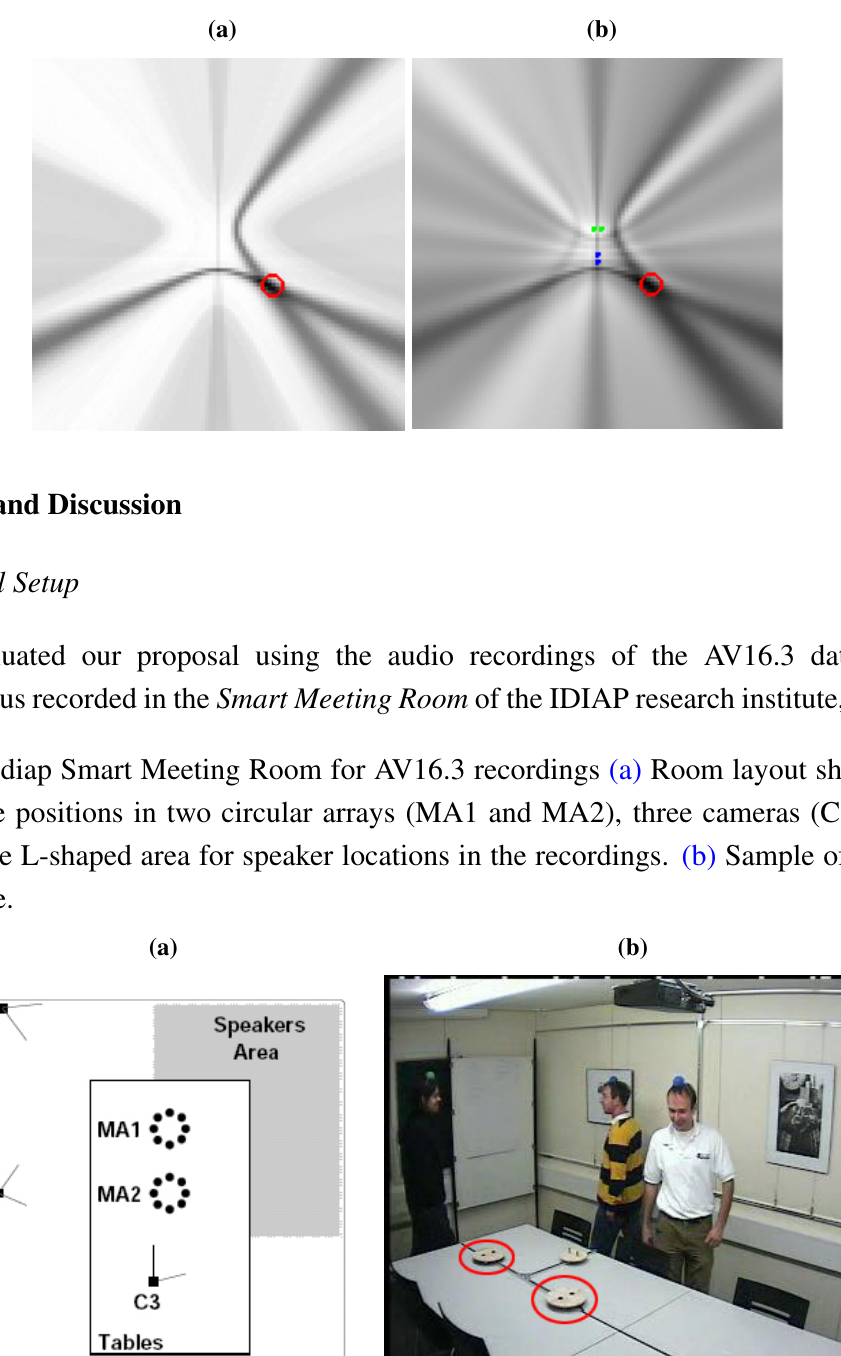
Figure 6. Comparison between real SRP-PHAT power map and its denoised version. (a) Denoised acoustic power map described by ˆ y (cid:48) ; (b) Real SRP-PHAT acoustic power map described by y